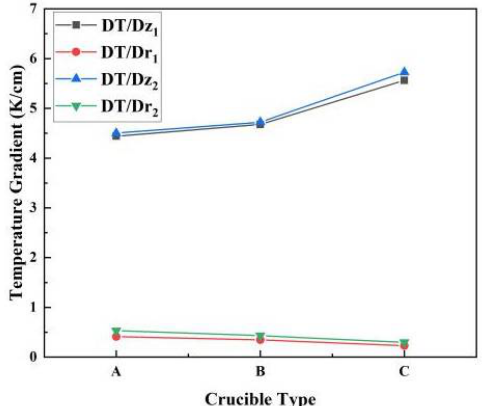
Figure 5. Comparison of temperature gradients in crucibles with different heat sinks. A, B and C designs represent designs with different bottom fin lengths; 1 and 2 represent tungsten sinks with and without the holder and top fin, respectively.